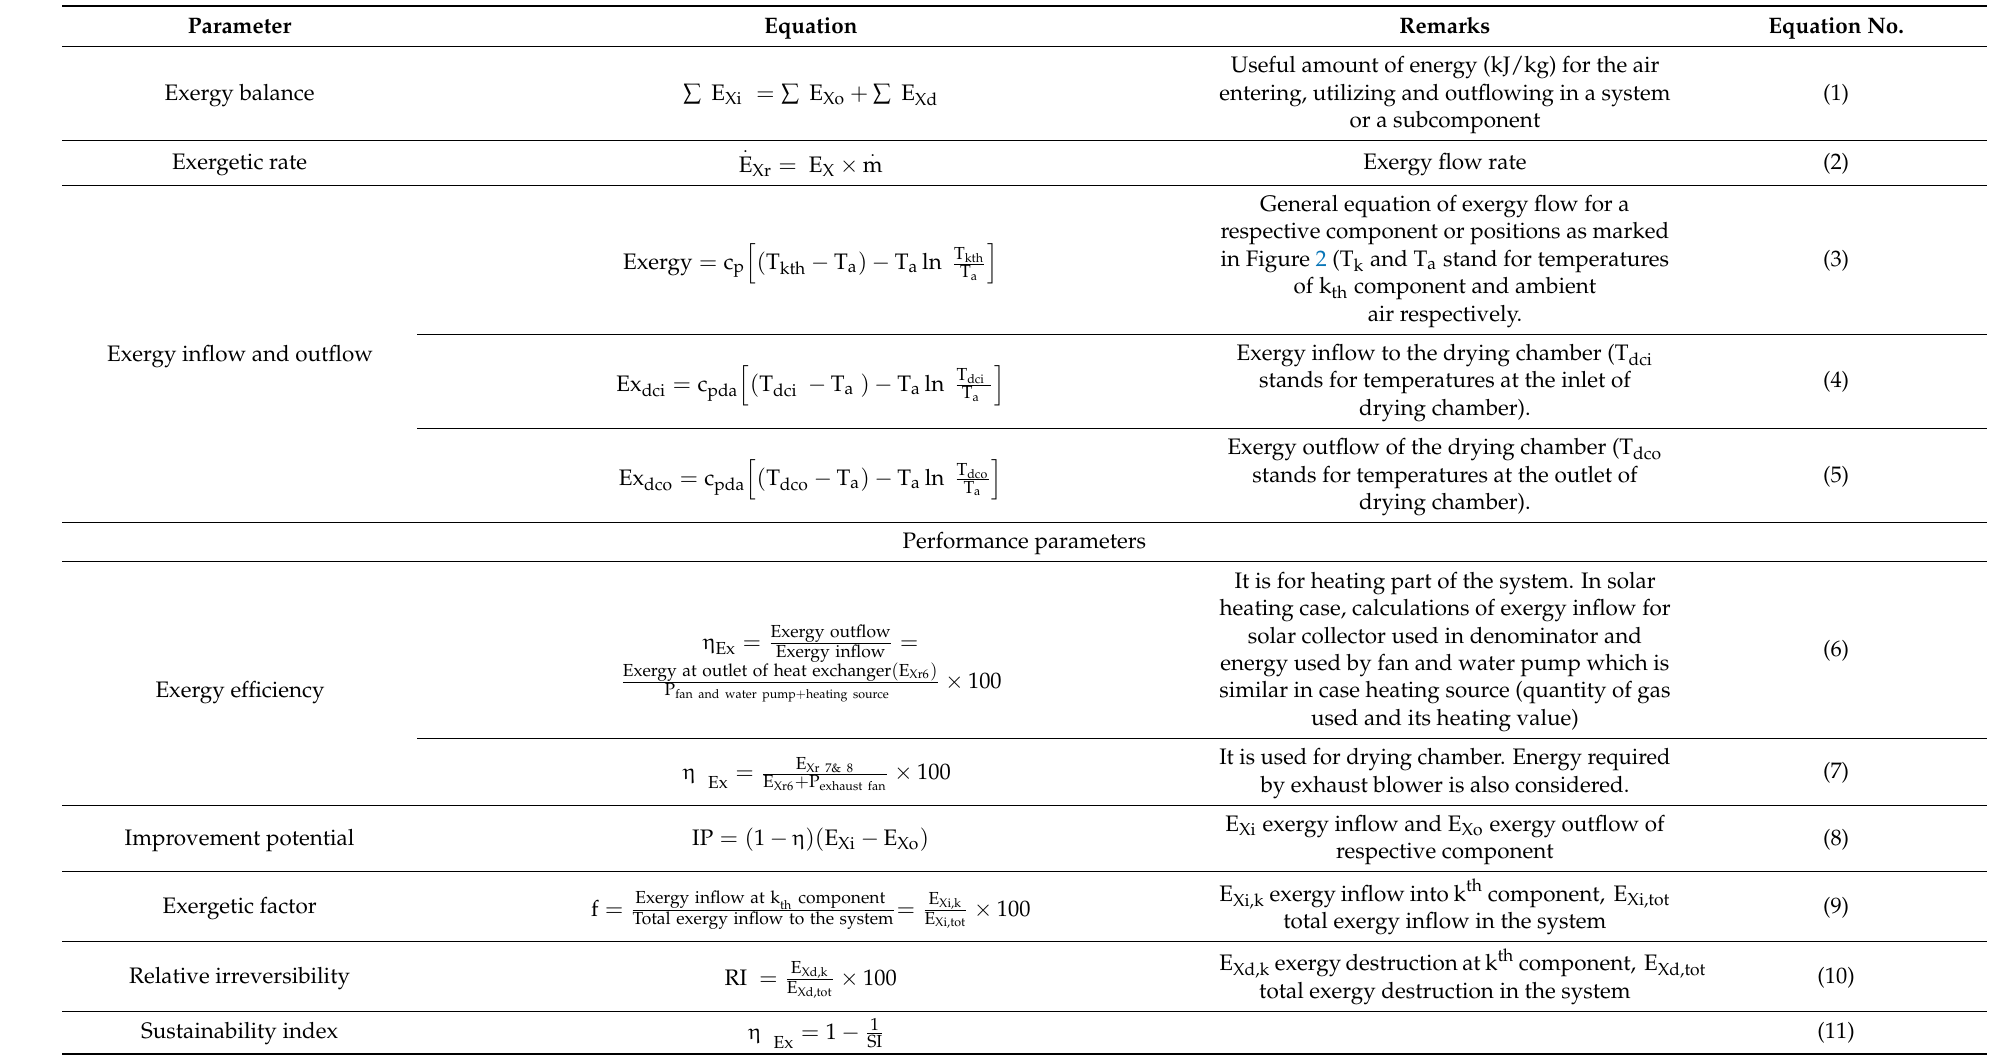
Table 1. Equations used for the calculations of different parameters used to conduct conventional exergy